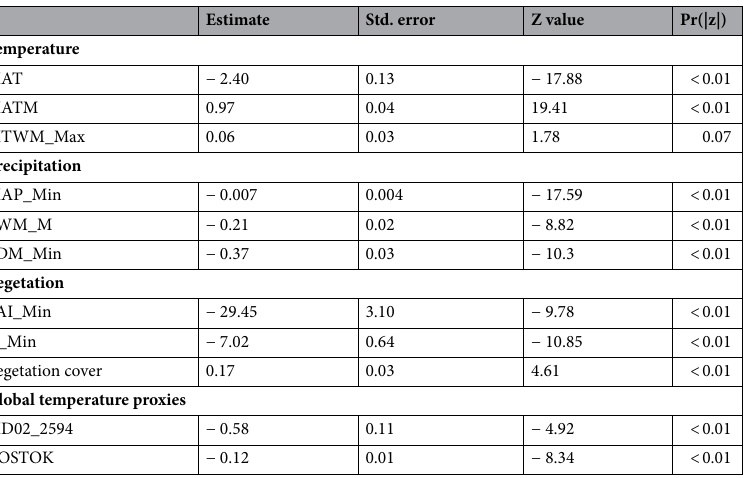
Table 2. Statistic GLMs (with zero-inflated poisson error structures and a log link function) at the number of backed pieces and different environmental/climatic proxies at local (i.e. Mean Annual Temperature (Minimum) = MAT, Mean Annual Temperature (Max) = MATM, Mean Annual Temperature Warmest Month = MTWM_Max, Mean Annual Precipitation (Minimum) = MAP_Min, Precipitation Wetest Month (Minimum) = PWM_M, Precipitation Driest Month (Minimum) = PDM_Min, Leaf Area Index (Minimum) = LAI_Min, Greenness (Minimum) = G_Min) and global level (MD02_25_94 and VOSTOK). Where bold indicate those proxies with a p ≤